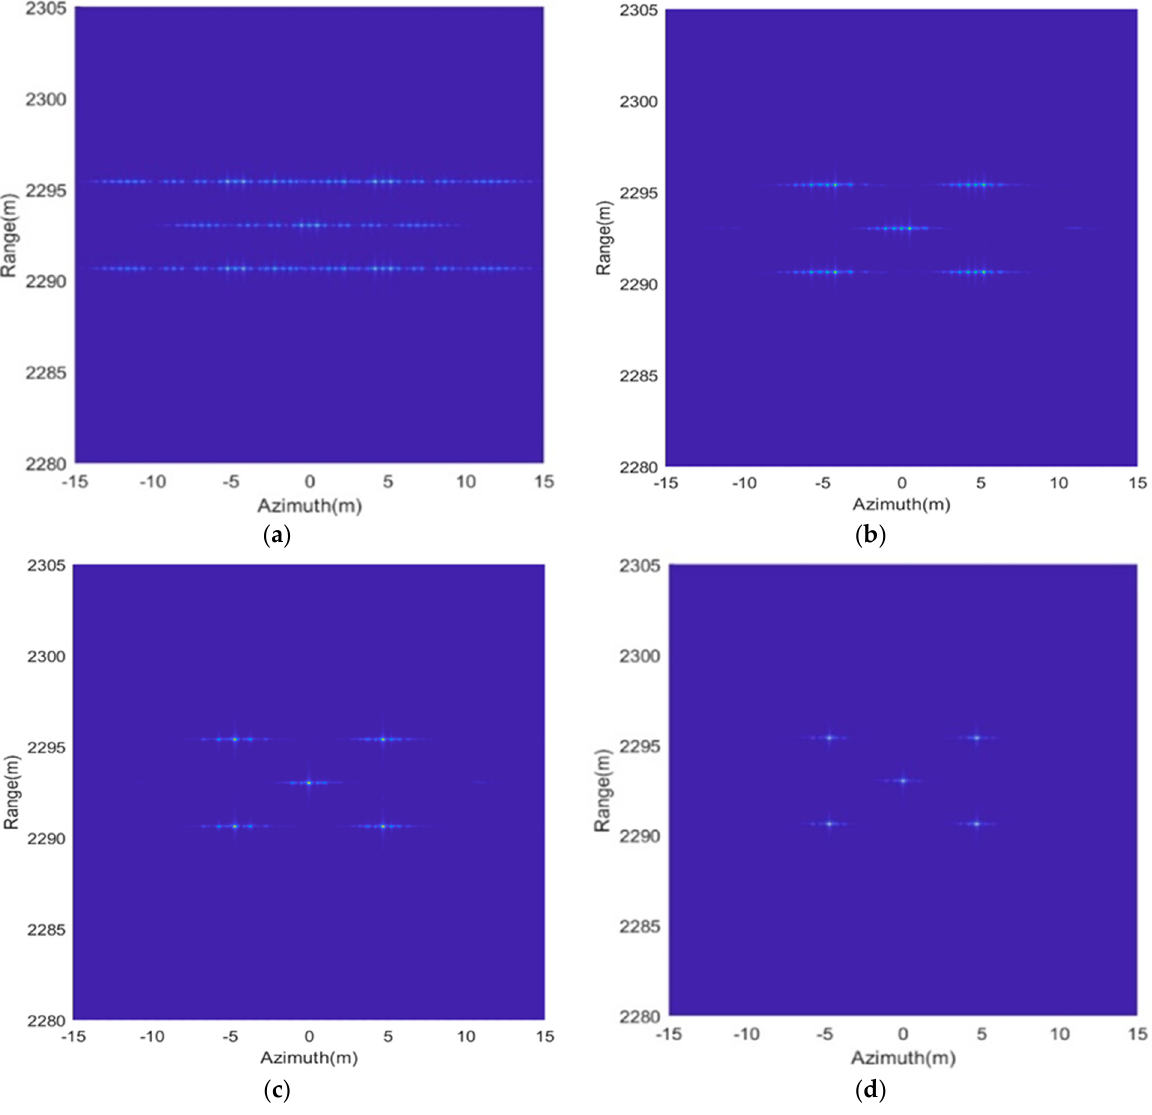
Figure 10. Comparison of compensation effect. ( a ) No compensation; ( b ) compensation based on STFT with ℎ = 20 ; ( c ) compensation based on STFT with ℎ (cid:3042)(cid:3043) = 26 ; ( d ) compensation based on STFT with ℎ (cid:3042)(cid:3043) = 26 and RANSAC.